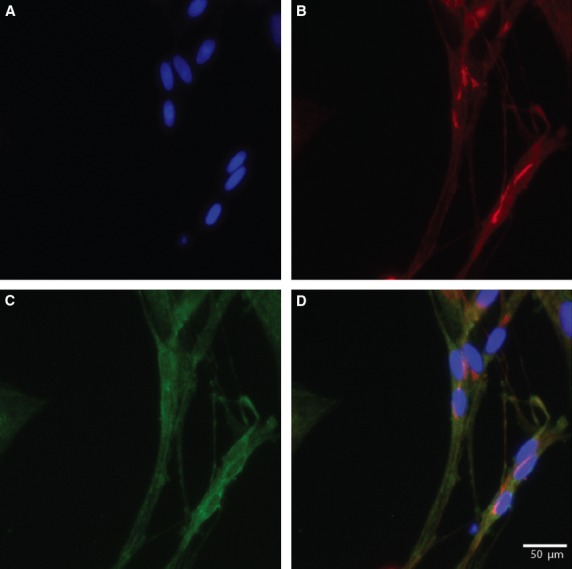
Immunocytochemistry of 7-day-old primary cultures of satellite glial cells from rat trigeminal ganglia. Image (A), shows the nuclei of the satellite glial cell stained with the nuclear stain Hoechst. The cultures are double labelled with antibodies against glutamine synthetase (Red: Alexa fluor® 555) (B) and SNAP-25 (Green: Alexa fluor® 488) (C). The merged image (D) is an overlay of all channels and this image shows the co-localization of glutamine synthetase and SNAP-25 in cultured rat trigeminal satellite glial cells. Virtually all SGCs seem SNAP-25 positive.